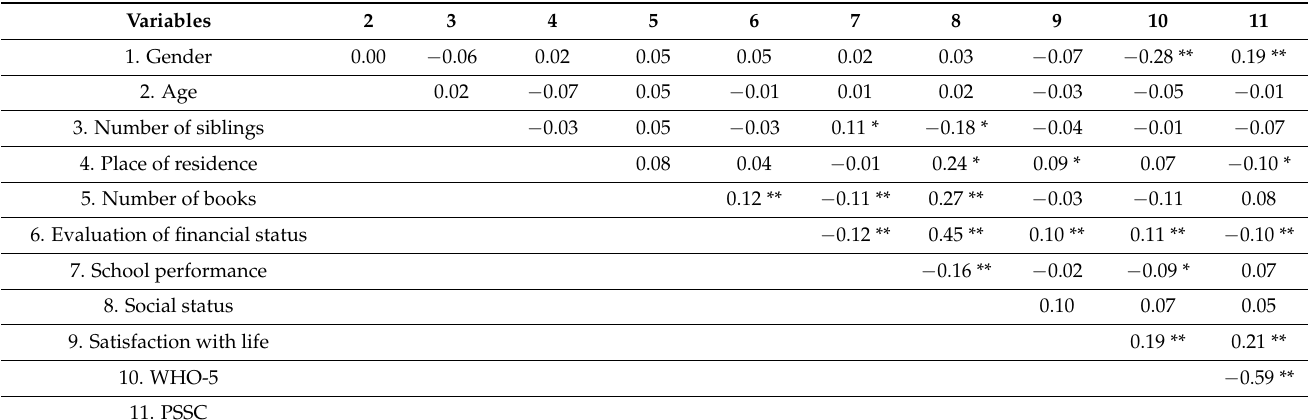
Table 4. Correlation coefficients.